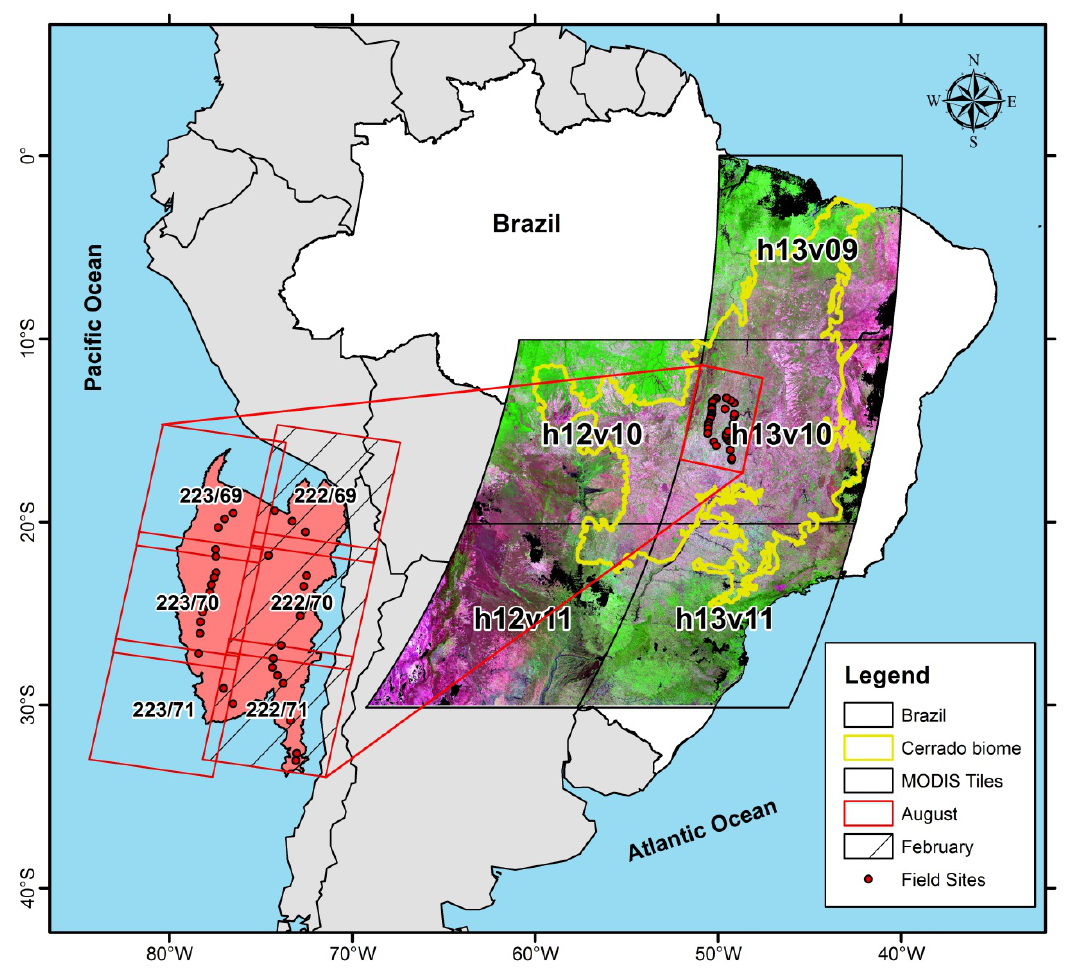
Figure 2. Location of the Landsat scenes (over the 27 field sampling sites) and MODIS tiles (over the entire Cerrado